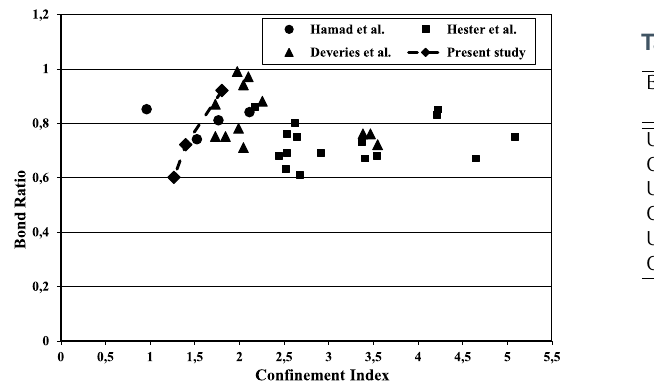
epoxy coated bars consistently failed at loads lower than those of the beams with uncoated bars. The ultimate load in beams with coated bars is 7%, 28% and 41% less than that of beams with uncoated bars for CI of for confinement indices 1.8, 1.4 and 1.26 respectively. The ratio of ulti- mate load carried by spliced beams to that of un-spliced beams is reported in Table 3. The ultimate load in beams with spliced uncoated bars is 75%, 60% and 58.24% of un-spliced beams for confinement indices of 1.8, 1.4 and 1.26 respectively. The ultimate load in beams with spliced coated bars is 68%, 43.55% and 34% of un-spliced beams for confinement indices of 1.8, 1.4 and 1.26 respectively.